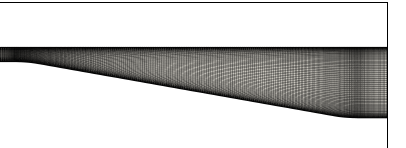
Figure 13. Schematic of the asymmetric diffuser case.